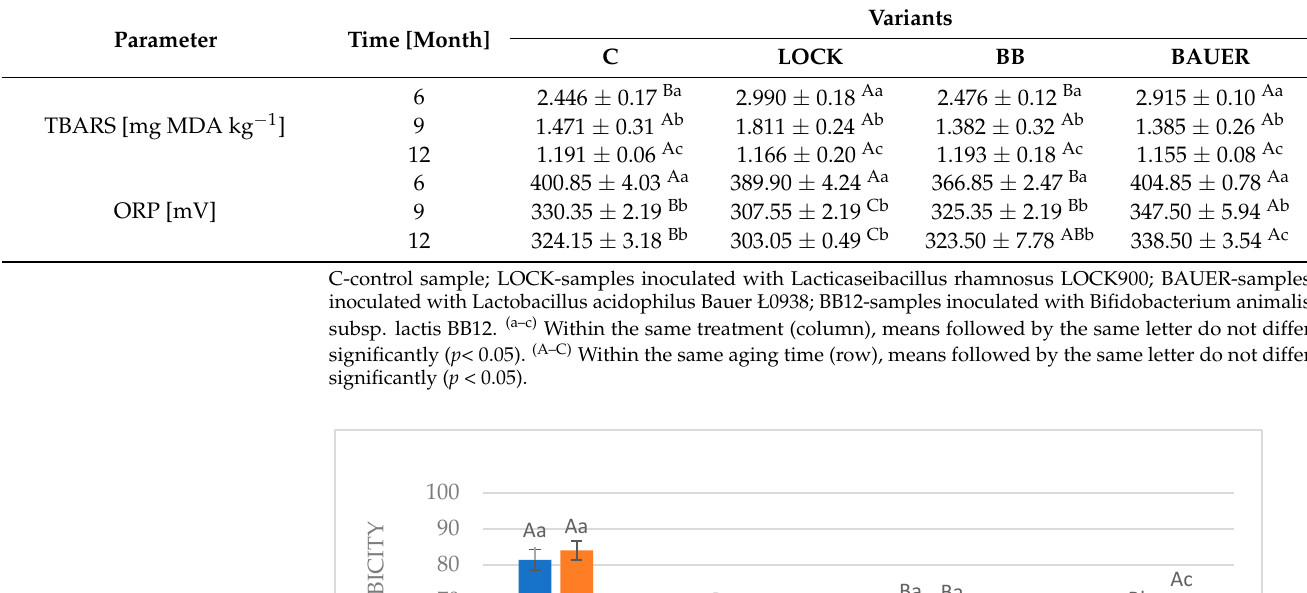
Table 3. Parameters determining the level of oxidation in fermented meat products.